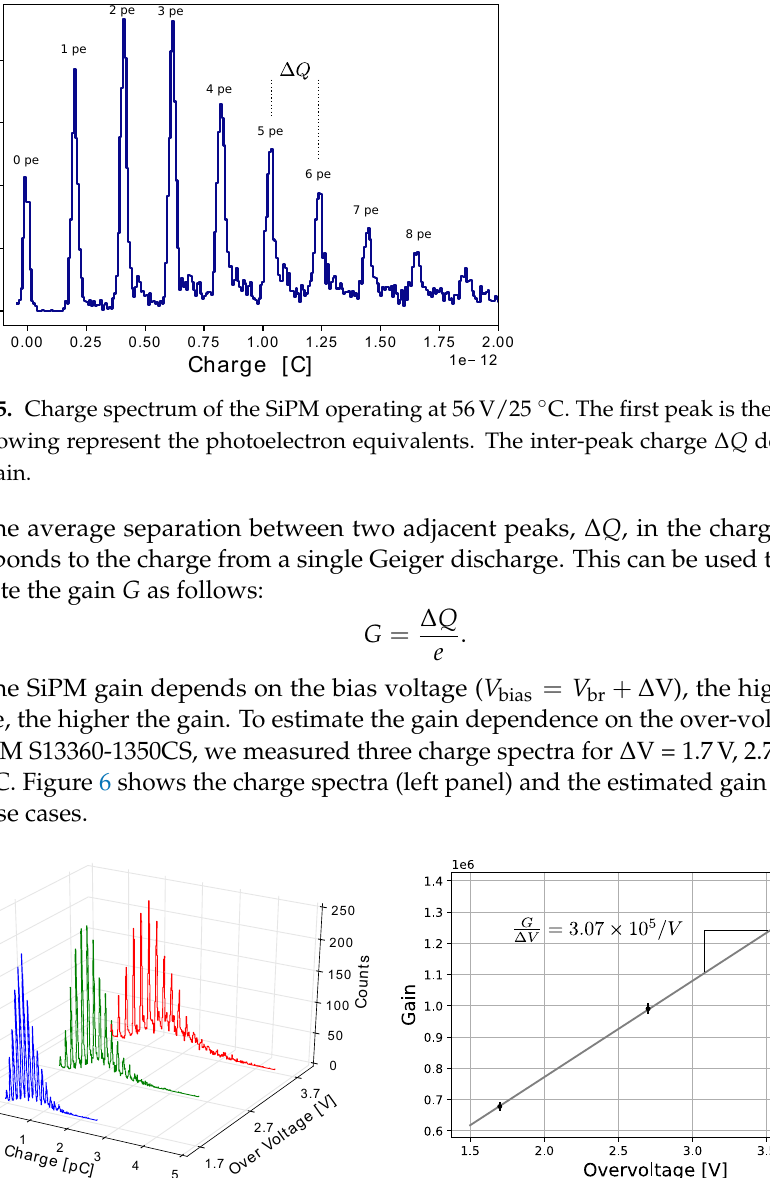
Figure 6. ( Left ): Charge spectrum for ∆ V = 1.7V (blue), 2.7V (green), and 3.7V (red). ( Right ): Mea- sured gain variation ratio depending on the